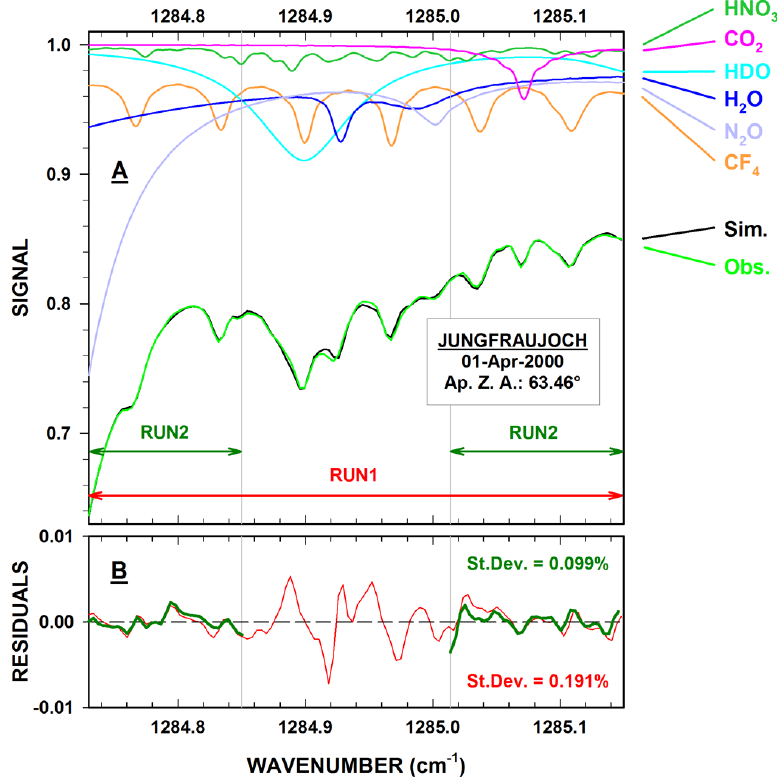
Fig. 1. Frame A displays the characteristic absorptions of CF 4 and the five most significant interfering gases in the “Run 1” micro-window selected for our CF 4 retrievals, computed for a typical ISSJ observation on 1 April 2000 (at 63.46 ◦ apparent solar zenith angle and 0.006cm − 1 resolution). Their combination results in the black simulation trace (labeled “Sim.”) which, compared to the actual observation (green curve, labeled “Obs.”) leads to the red residuals (observed minus calculated signals) in Frame B. Because of strong perturbations by the H 2 O and HDO interferences, this initial “Run 1” was followed by a second composite “Run 2”, with corresponding residuals displayed by the thick green trace in Frame B.